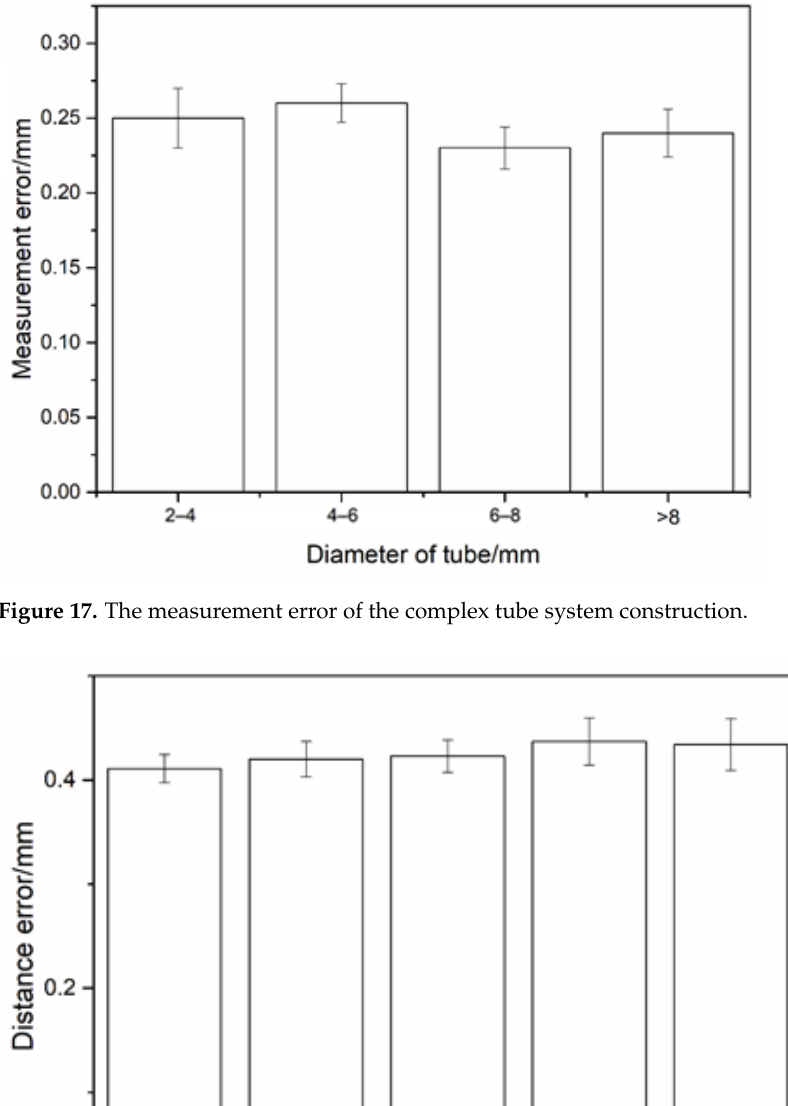
Figure 18. Distance error of the complex tube system construction.